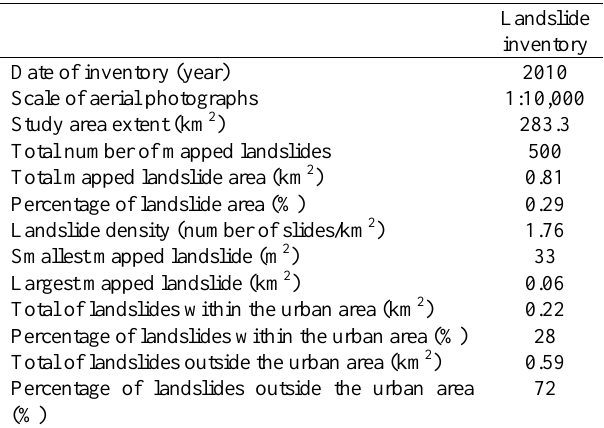
Table1. Statistics from the landslide inventory for the Brusque region.